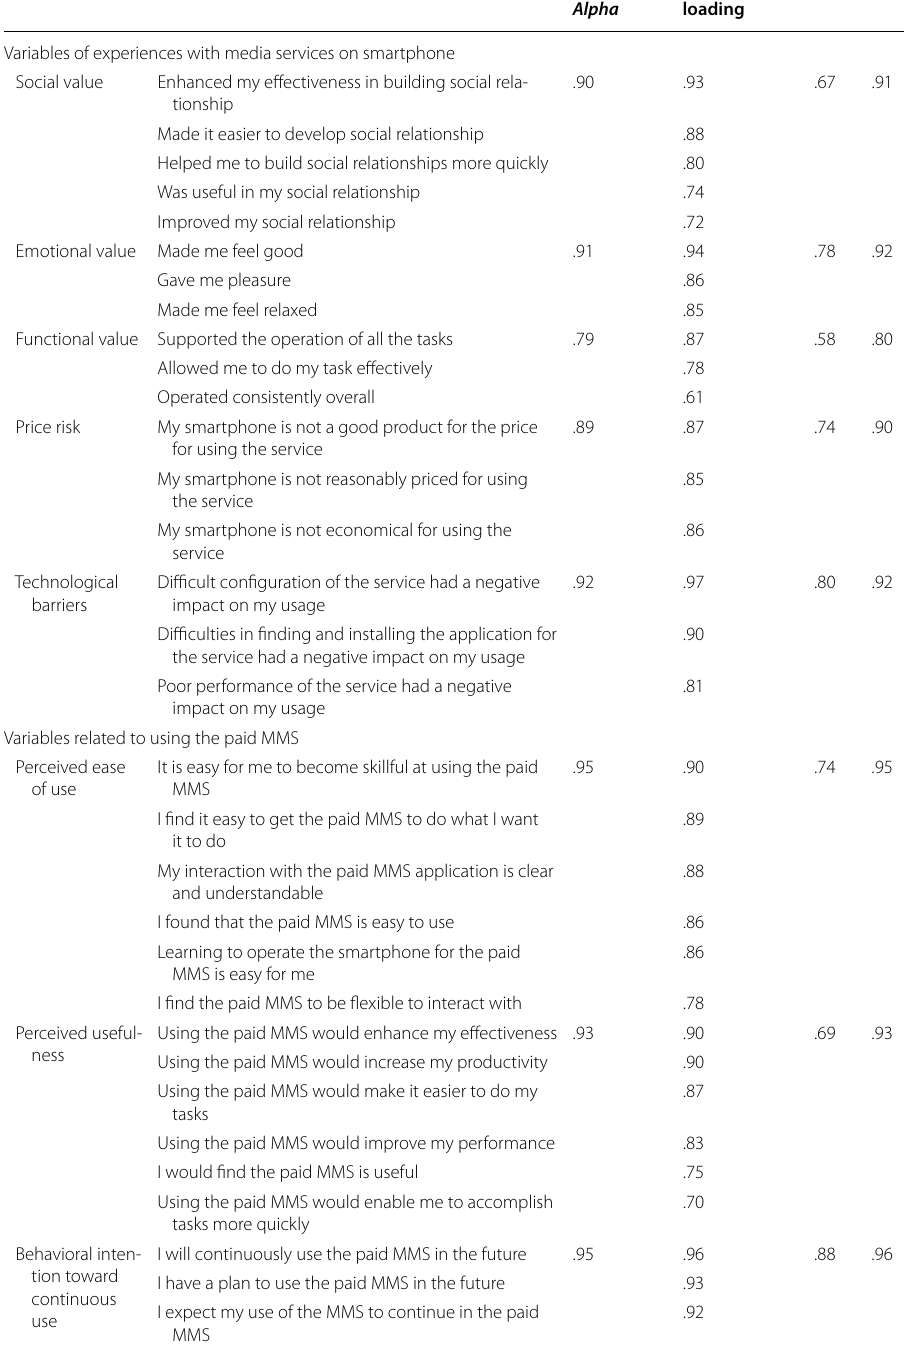
Table 1 Results of measurement